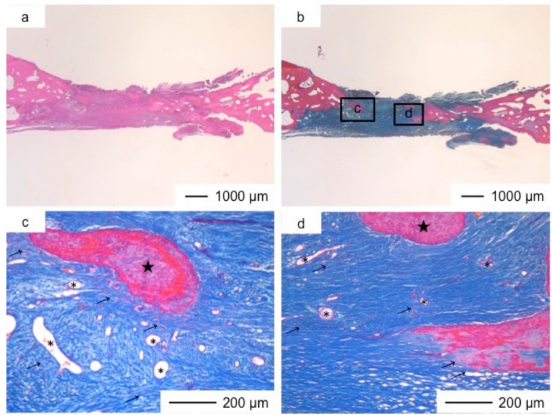
Figure 8. Light microscopic images of ChGCa_HAp in cranioplasty three years after implantation, stained by HE ( a ) and AM ( b ); ( c , d ) Magnifications of the insets in ( b